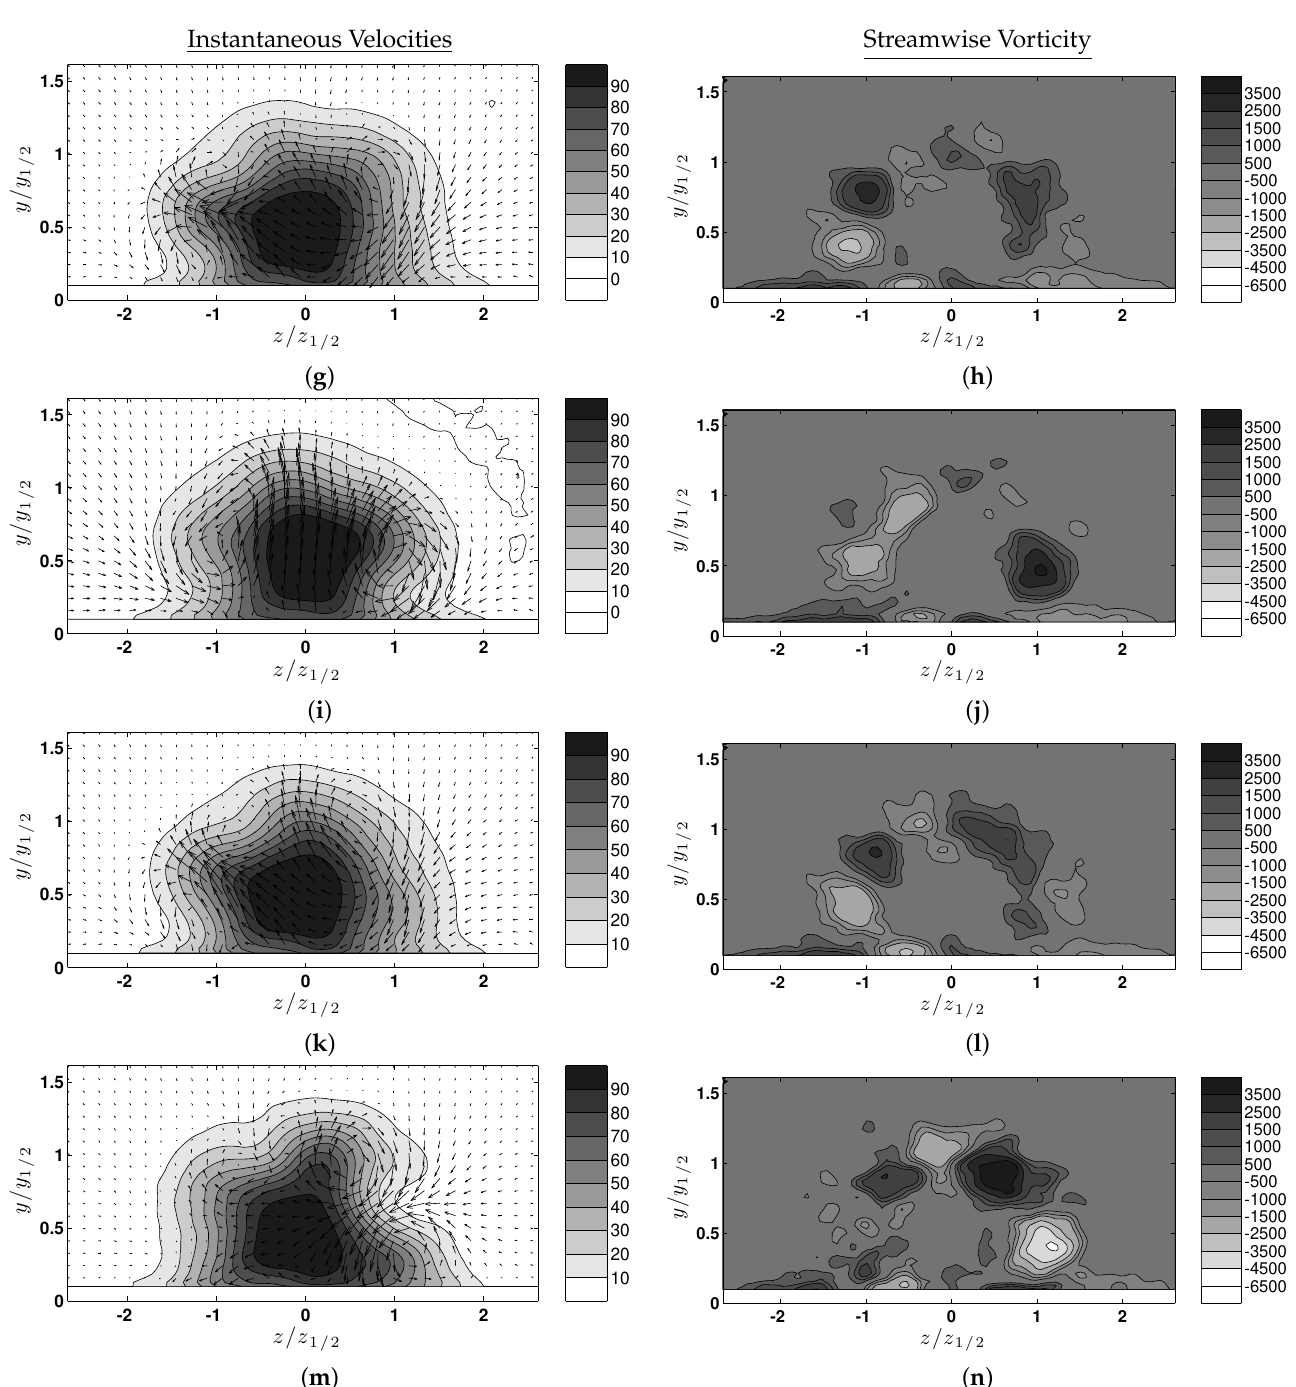
Figure 5. POD reconstruction of the instantaneous velocity ( m / s ) using the first 10 modes and the reconstructed instanta- neous streamwise vorticity ( 1/ s ) at x / D = 5. The mean streamwise velocity (normalized) and mean streamwise vorticity are shown in the first